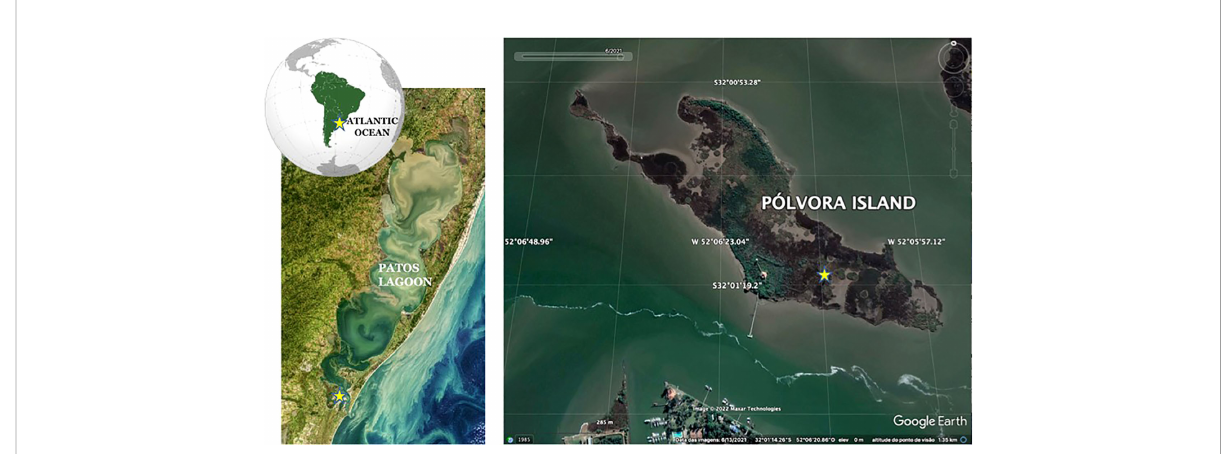
FIGURE 1 Location of the Patos Lagoon in southern South America and Pólvora Island in Patos Lagoon Estuary. The study site is represented by the yellow star in the consecutive maps. (left) Landsat 8 (OLI) image of Patos Lagoon of 24 May 2018 provided by NASA Earth Observatory. (right) Pólvora Island image of 13 June 2021 provided by Google Earth Pro ®